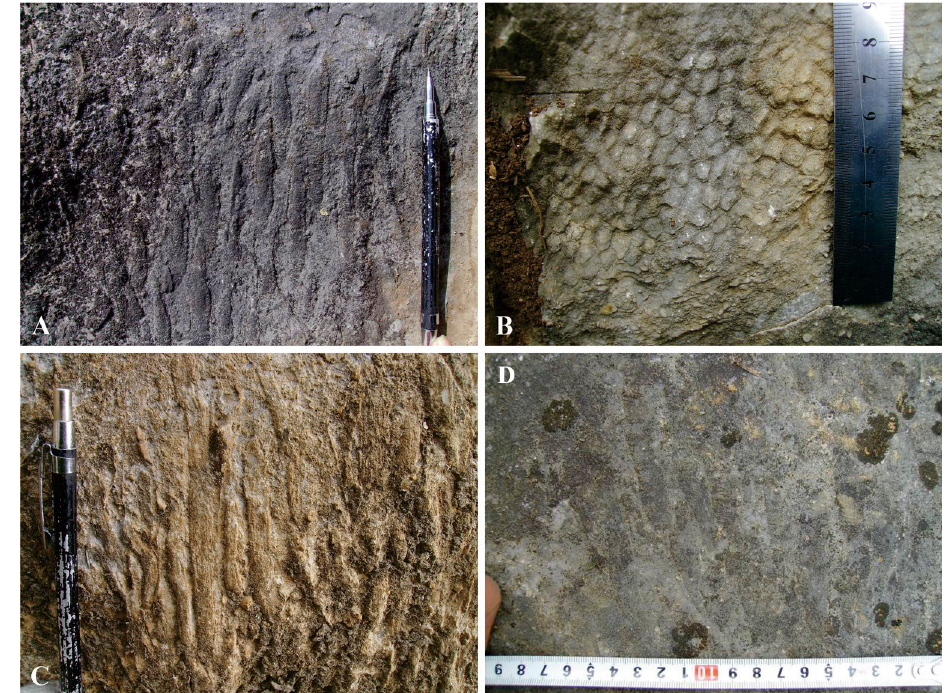
Figure 9. Main reef-building corals in the study area. ( A ) Diphyphyllum, ( B ) Lithostrotion, ( C ) Siphonodendron, ( D ) Lonsdaleia . ( A ) Rapidly grew clusters of main reef-building corals. The strong individuals are packed